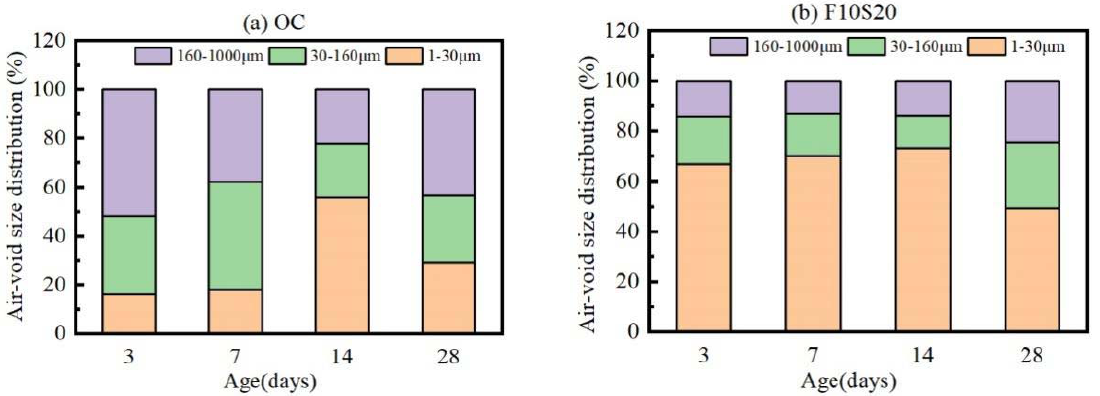
Figure 11. Air ‐ void distribution of ( a ) OC and ( b ) F10S20 concrete at different ages. Figure 11. Air-void distribution of ( a ) OC and ( b ) F10S20 concrete at different ages.